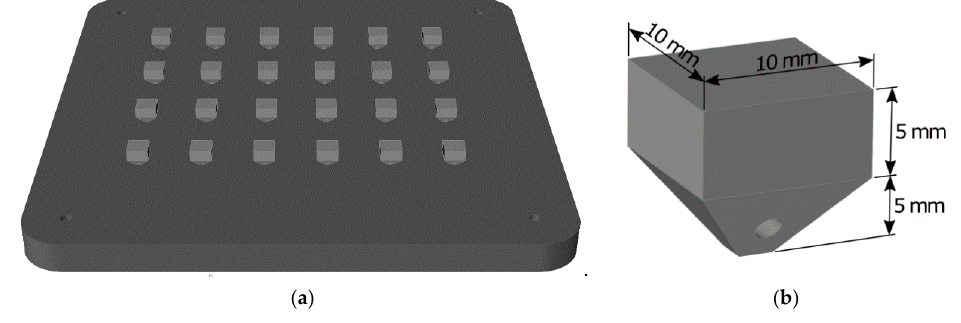
Figure 2. ( a ) Twenty-four manufactured cubes; ( b ) dimensions of the samples.